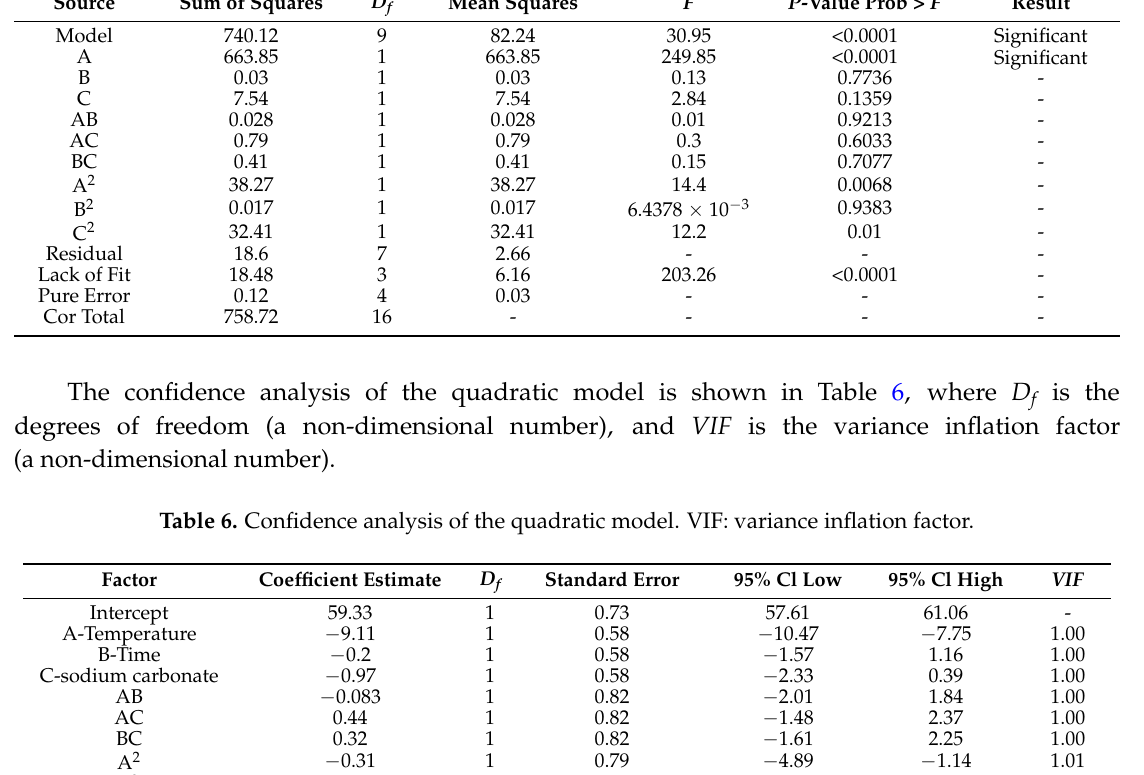
( b ) Figure 4. ( a ) Response surface of heating temperature–heating time plot; ( b ) contour of heating temperature–heating time plot. ( a )